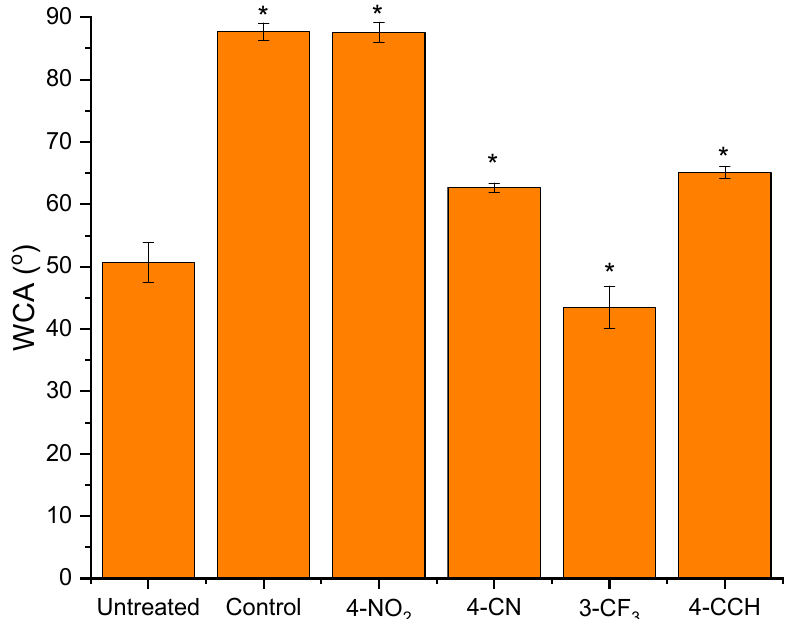
Figure 3. Water contact angles (WCA) for untreated, control, and functionalised membranes used in this study. Errors are standard deviation, * denotes statistically significant difference to untreated sample, P < 0.05.